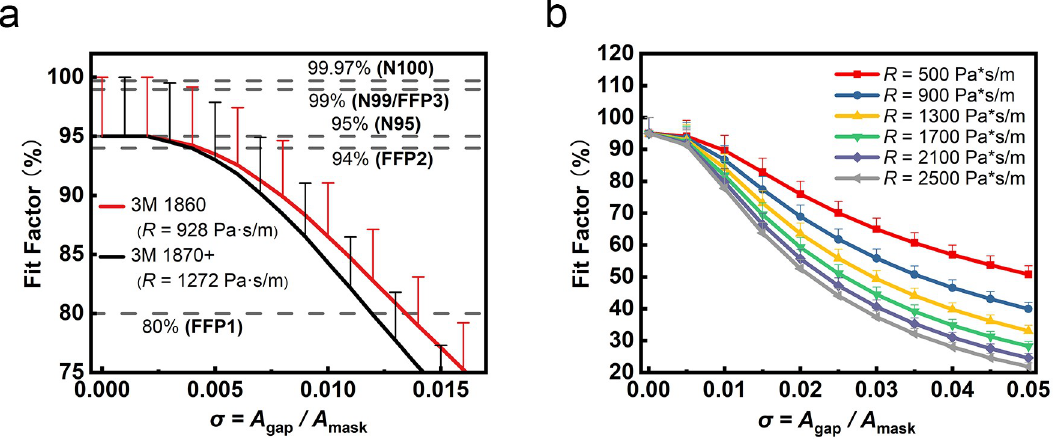
Fig 7. The results of gap area vs. fit factor. For (a) representative commercially available masks (3M 1860 and 1870+) and (b) N95 masks with various ventilation resistances.